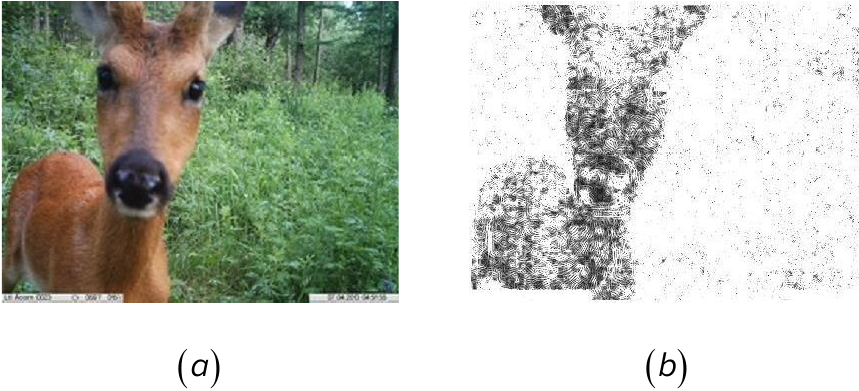
Figure 8. Texture parameters extraction; ( a ) Input image; ( b ) texture image.